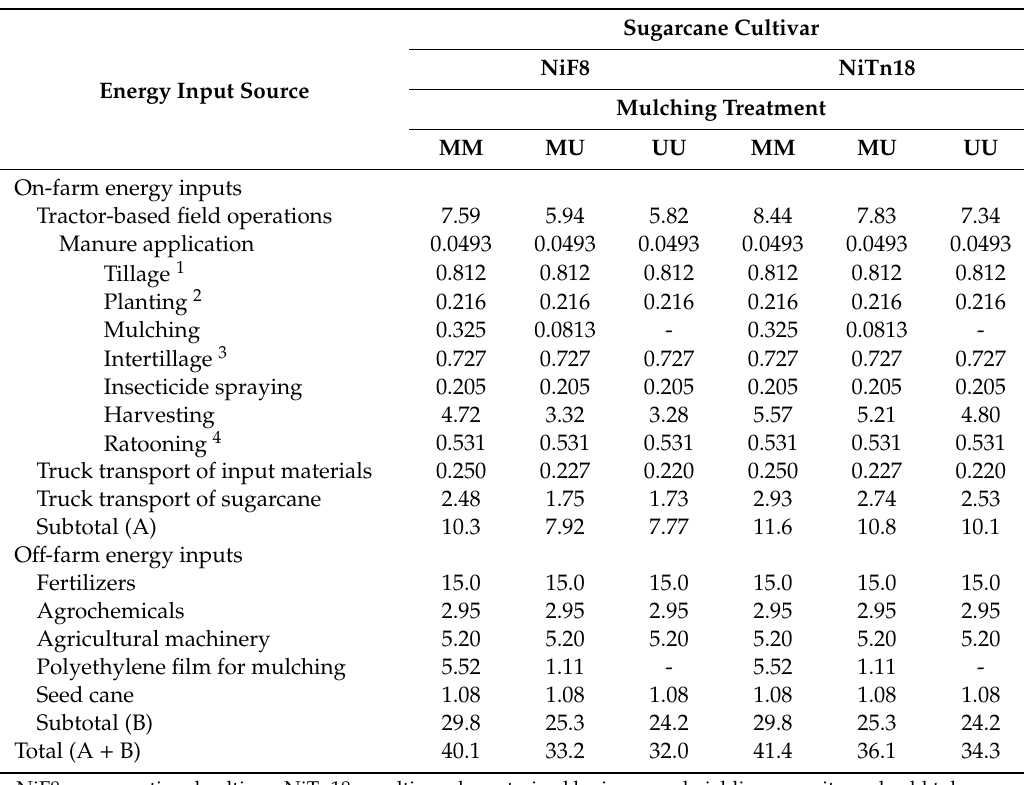
Table 3. Energy inputs (GJ ha − 1 year − 1 ) estimated for the combined cultivation systems of three polyethylene mulch treatments and two